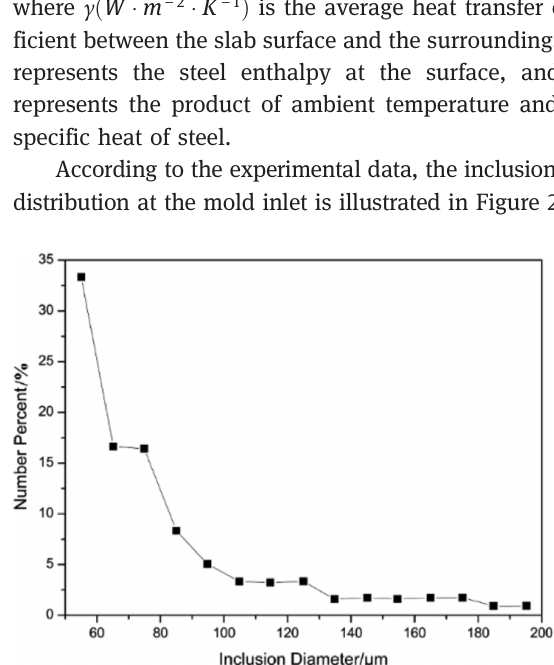
Figure 2: Inclusion distribution at the mold